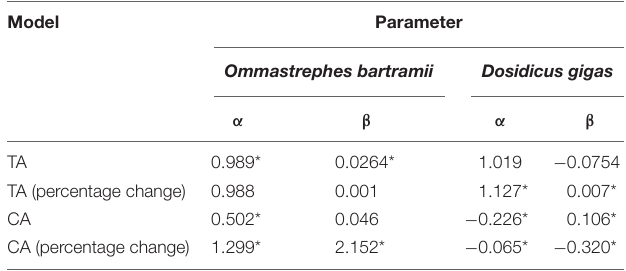
FIGURE 10 | Cross-validation results of 153 sub-models of generalized additive models (GAM) for the annual trend of the abundance of D. gigas (CA). (A) Model-predicted and actual CA; (B) model-predicted residual and actual CA; (C) model-predicted and actual CA percentage change compared with the last year (except for 2003 in which it is compared with the year 2004); (D) the model predicted the residual and actual value for CA percentage change compared with the last year.